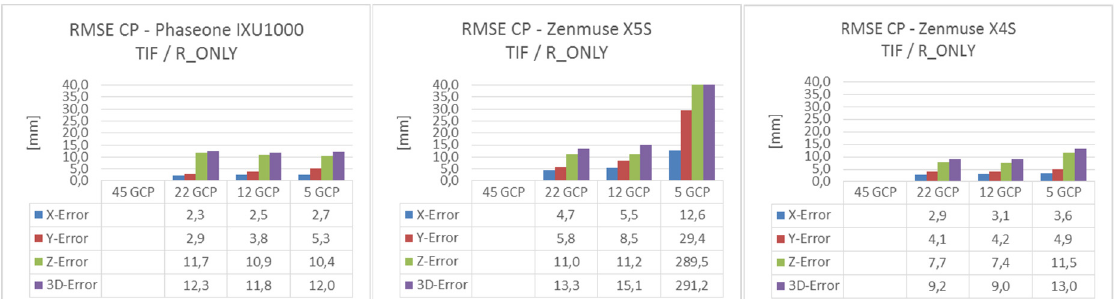
Figure 8. RMSE values at CPs. Flight arrangement: R+C. TWO sets of interior orientation parameters (SEPARATE). Calculation: Agisoft PhotoScan.